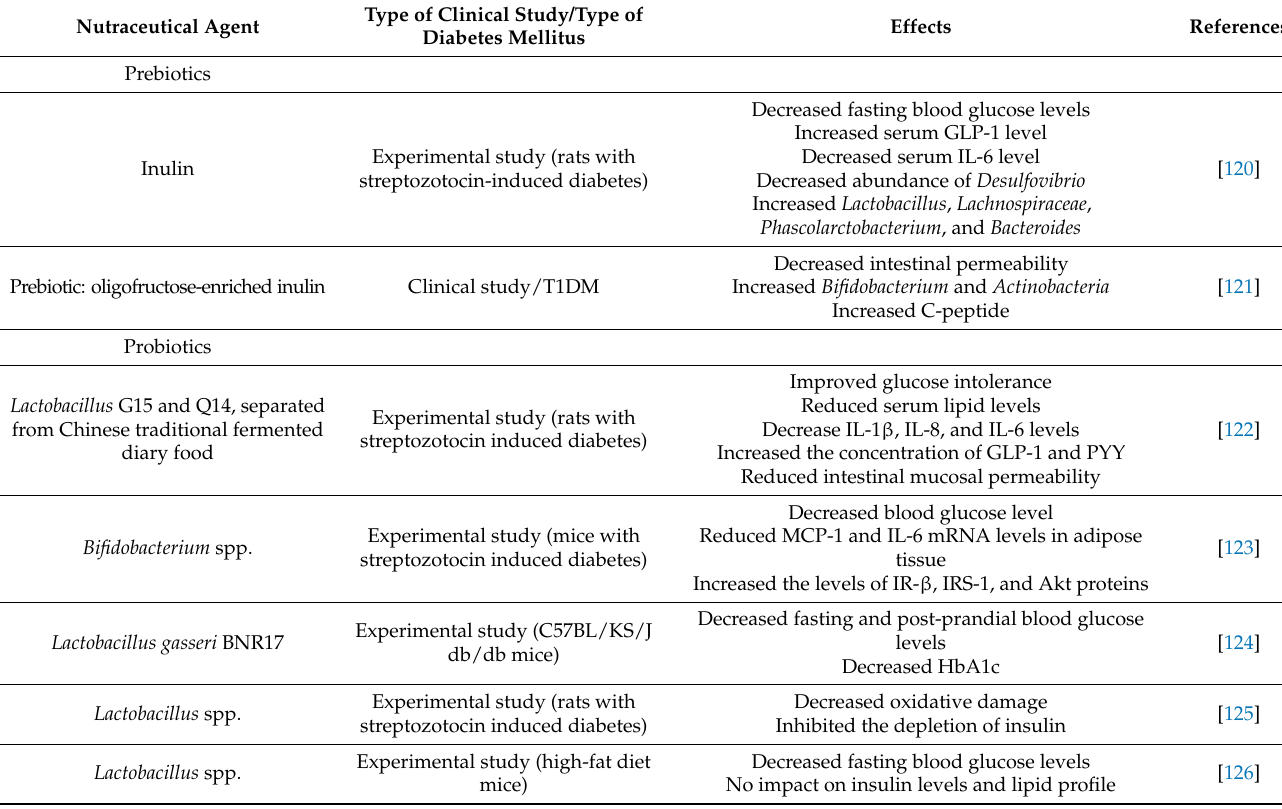
Table 2. Nutraceutical agents influencing the gut microbiota in experimental and clinical